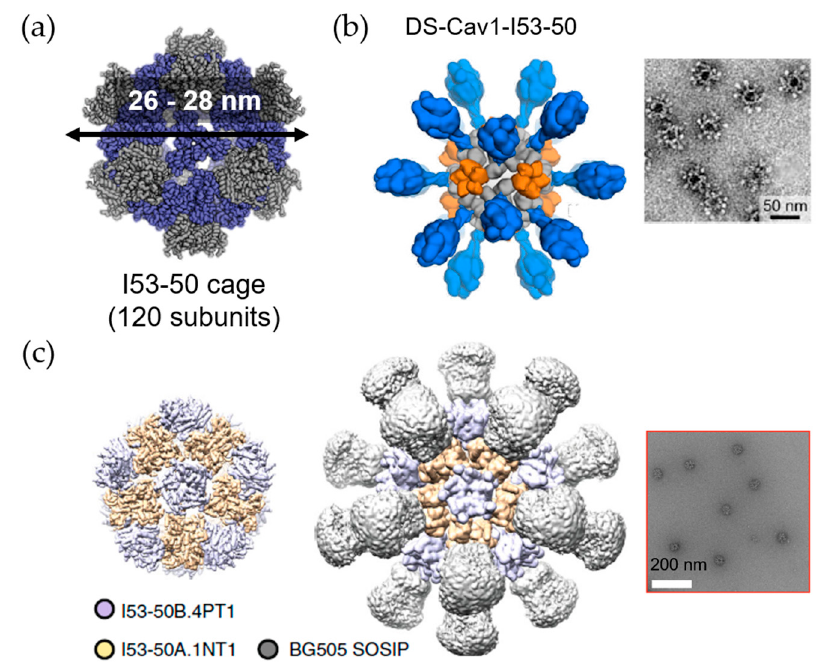
Figure 8. The utilization of I53-50 cage in vaccine design. ( a ) Design of I53-50 cage composed with 120 subunits of two component proteins. Modified from [71]. Reprinted with permission from American Association for the Advancement of Science (AAAS). ( b ) The utilization of I53-50 as a carrier for respiratory syncytial virus antigen (DS-Cav1) conjugation; and ( c ) HIV-1 antigen (BG505 SOSIP) conjugation with negative stain electron microscopy (EM) images on the right side, respectively. Reproduced with modification from [72] and